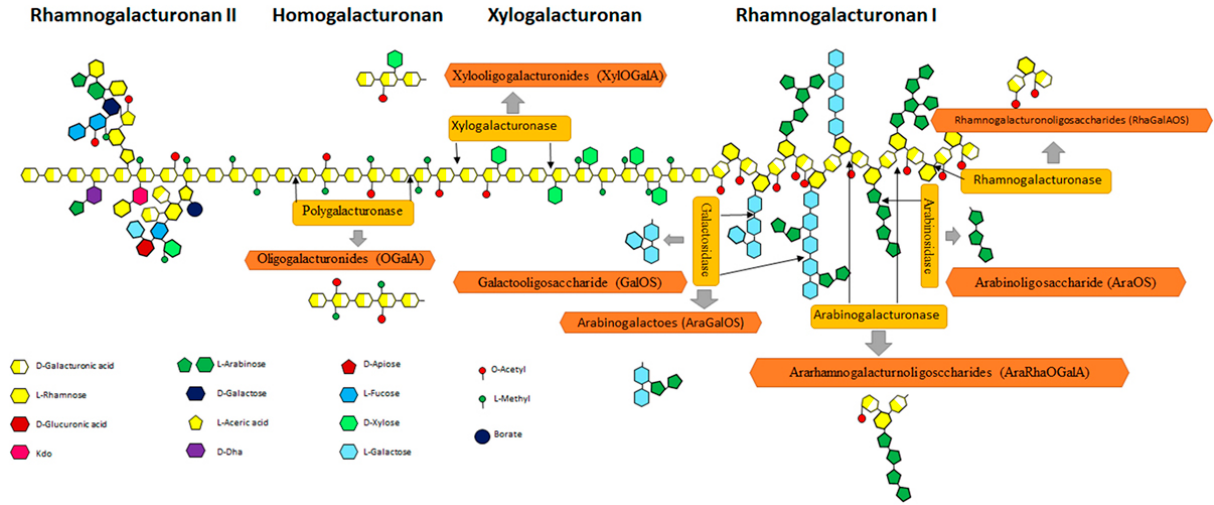
Figure 3. Representation of the chemical structure of Pec